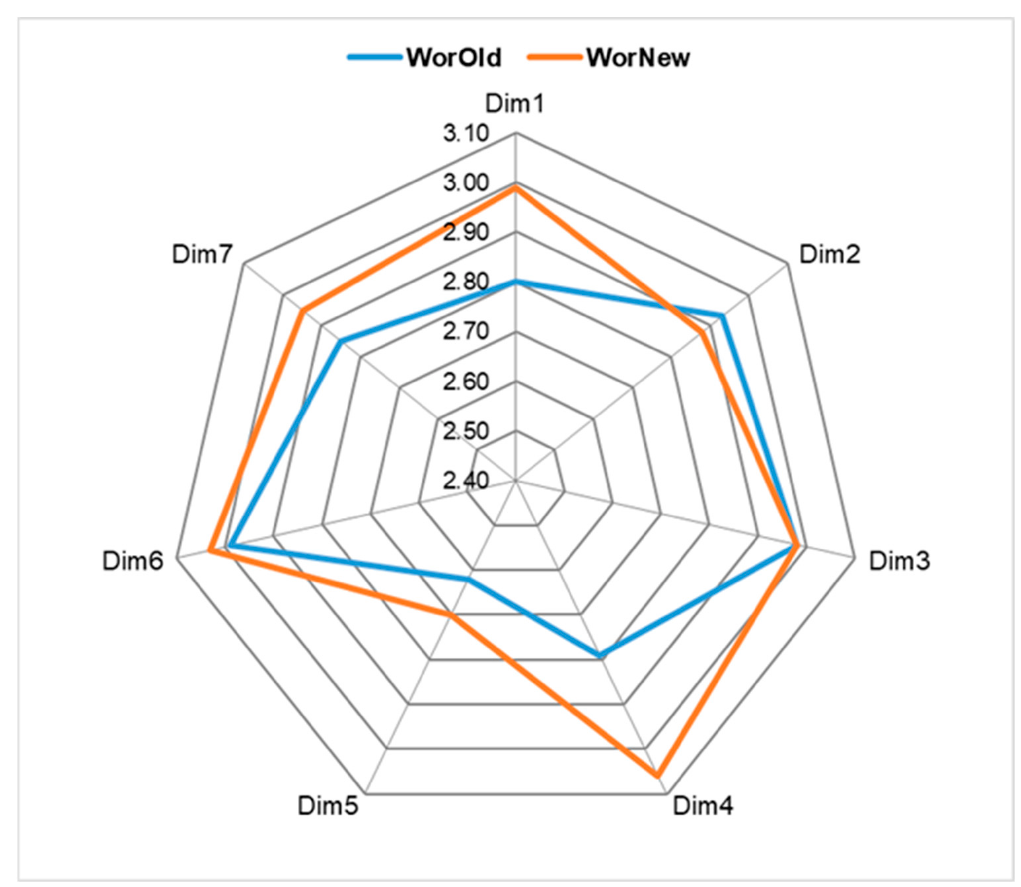
Figure 7. Results of the responses of managers to NOSACQ-50 in the current study (WorNew) compared to those of previous research [8] (WorOld).